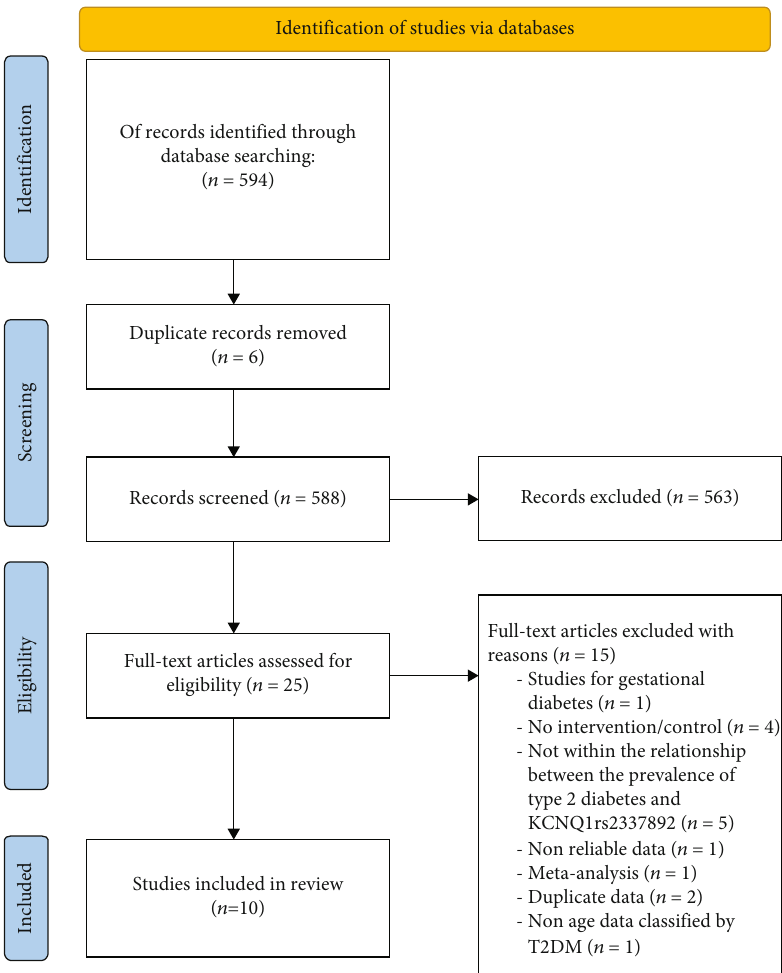
Figure 1: Literature screening